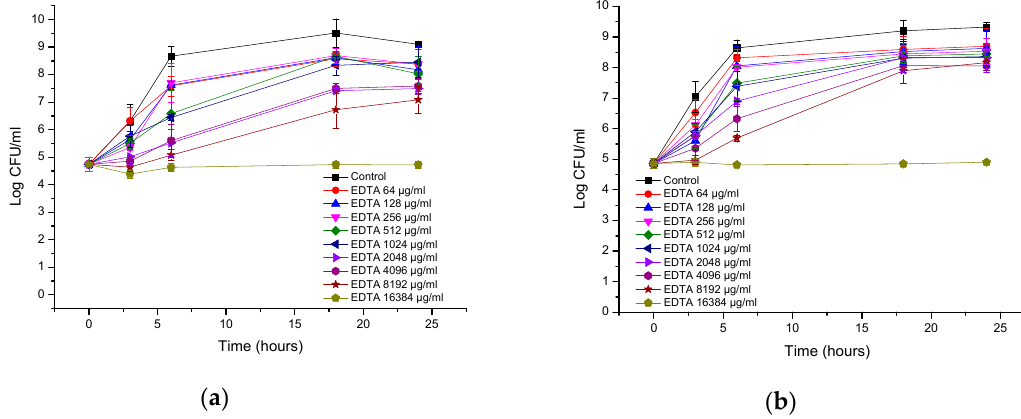
Figure 4. Time-kill curves of EDTA (etlylenediaminetetraacetic acid) against ( a ) Escherichia coli ATCC (American Type Culture Collection); ( b ) Escherichia coli ESBL (extended spectrum beta lactamase).